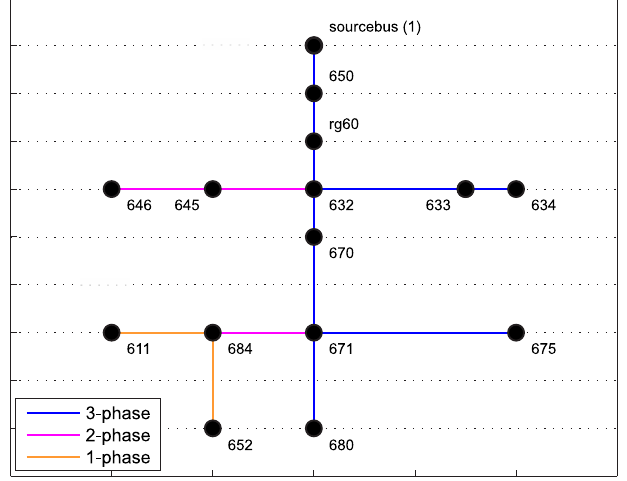
Figure 8. Small-size